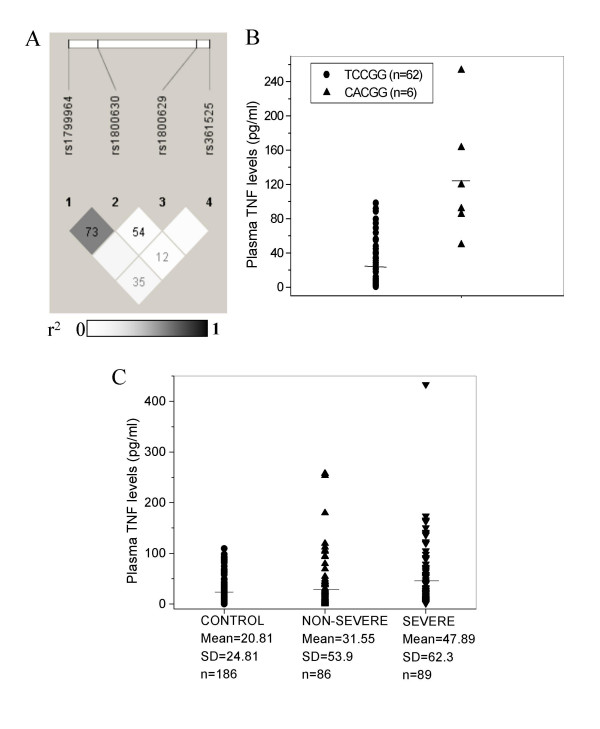
Linkage between TNF regulatory region SNPs and correlation of TNF haplotypes with plasma TNF levels. A, r2 LD plot of four TNF SNPs (-1031, -863, -308, -238). Value in each cell is the percent D' between SNP pairs. B, Correlation of TNF promoter haplotype (-1031C, -863A, -857C, -308G, -238G) with elevated TNF levels compared to the major haplotype TCCGG. Mean plasma TNF levels were compared using Mann-Whitney test (z = -3.73, P = 0.0002). C, Plasma TNF level in patients and controls. Pairwise comparison of means by non-parametric Mann-Whitney test: severe versus control, z = 4.41, P < 0.0001; non-severe versus control, z = 0.67, P = 0.25; severe versus non-severe, z = 3.13, P = 0.0009.